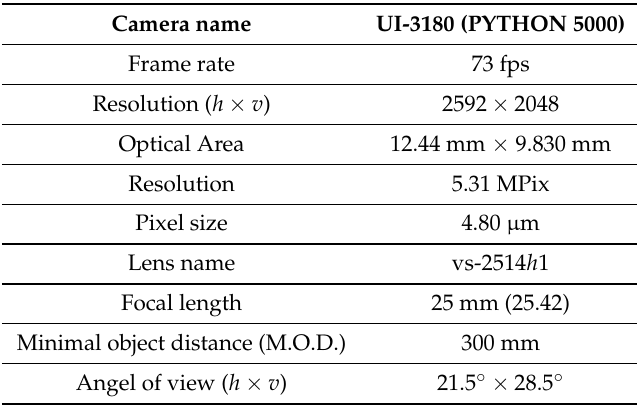
Table 1. Inspection camera specifications.